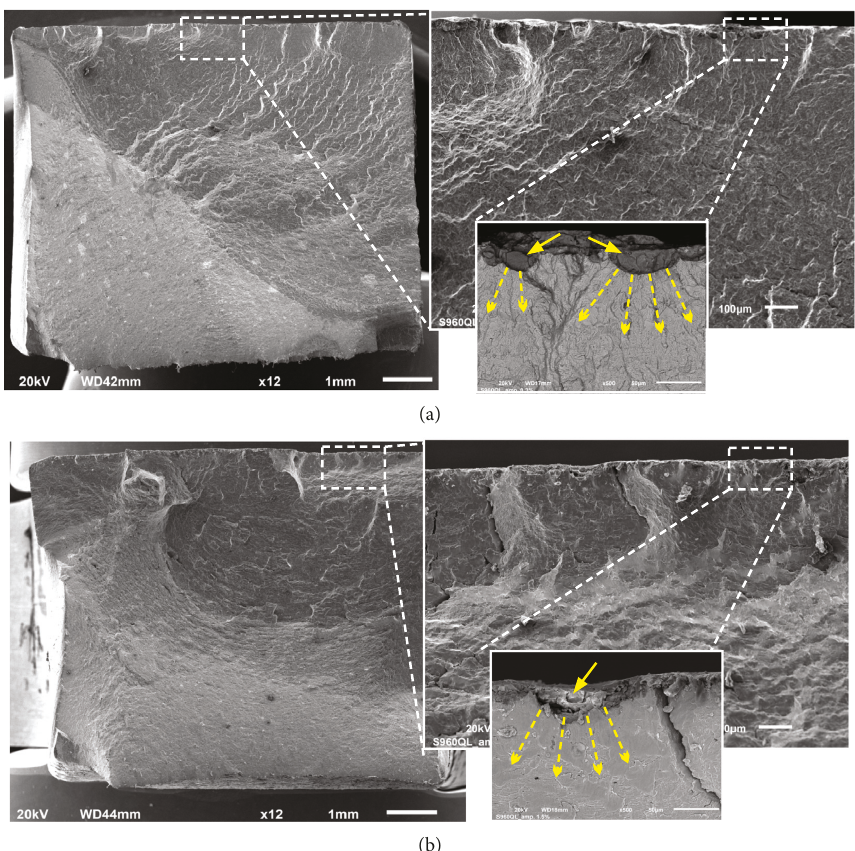
Figure 5: The pictures of fatigue fractures have been observed during fractographic investigation. Samples made of S960QL steel tested under total strain amplitude: (a) ε a � 0.3% and (b) ε a �